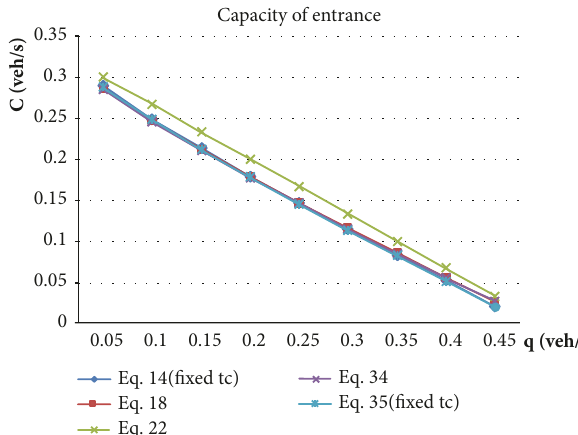
Figure 3: Calculation of entrance capacity under different flow rates on circulating